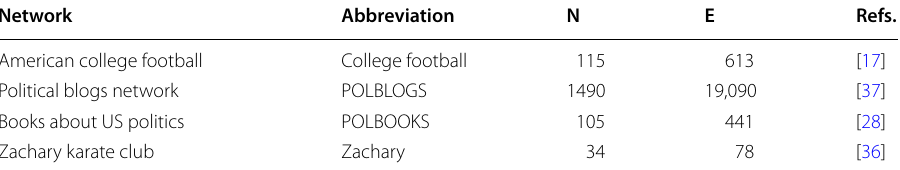
Table 4 Datasets